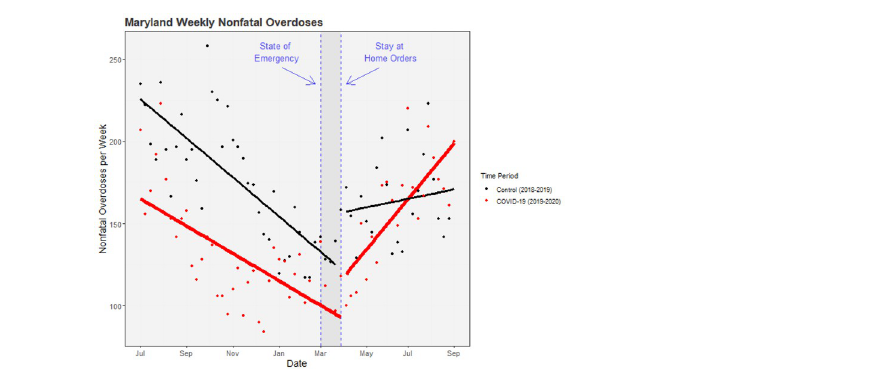
Fig 2. ITS adjusted weekly nonfatal overdose counts in Maryland state pre- and post-Covid-19 public health orders. Points represent weekly counts of suspected nonfatal overdoses. Solid lines represent ITS-model-predicted counts: red for the Covid-19 time series (including March 2020), black for the preceding time series (including March 2019). Dashed horizontal lines mark the official declaration of a state of emergency (March 5th, 2020) and stay-at- home orders (March 30th, 2020) in Maryland state.